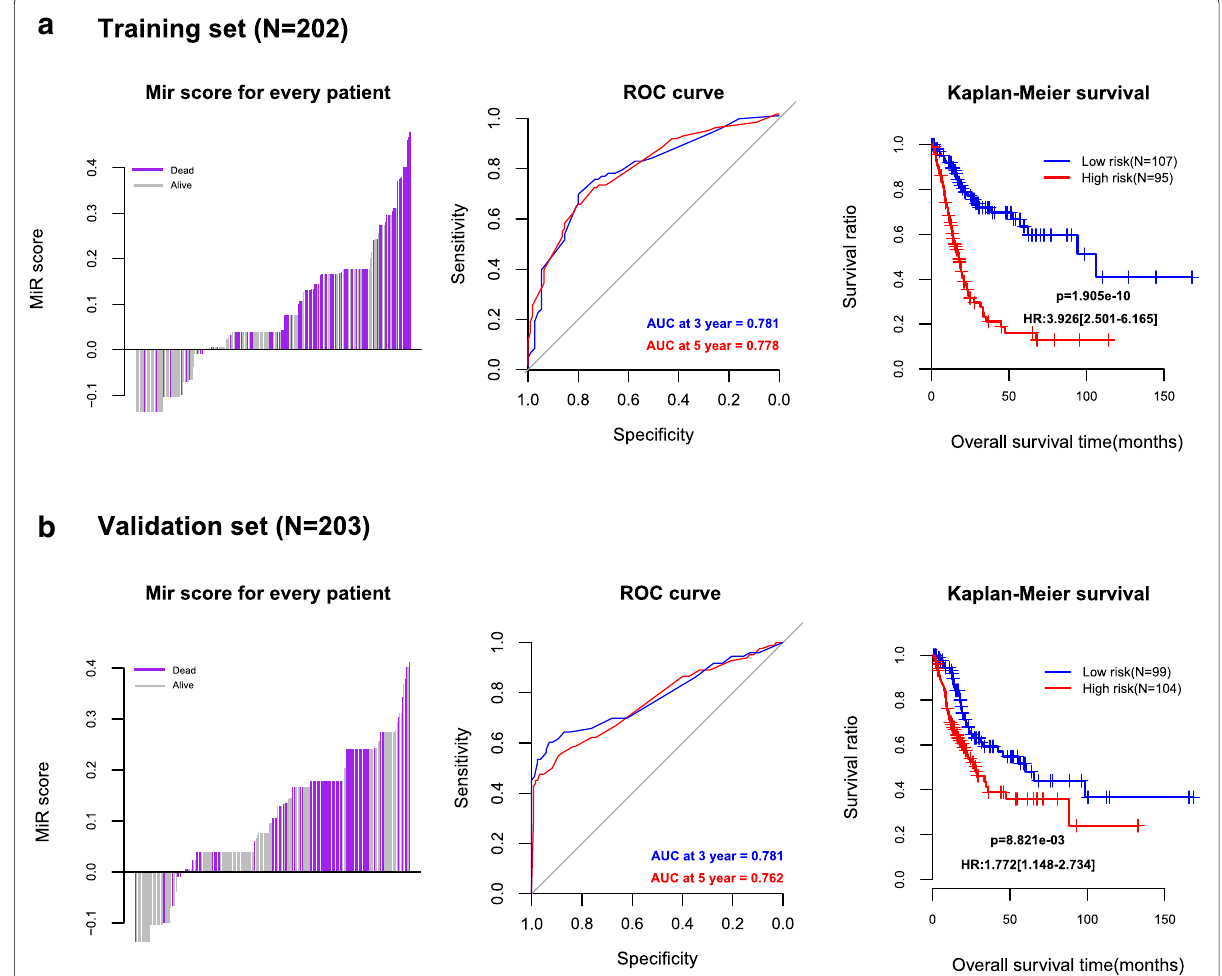
Fig. 3 a The sample distribution ofthe MiR Score in the training set (left), purple and gray bars represent samples of death and survival, respectively; ROC curve analysis of 3- and 5-year survival for MiR Score risk assessment model in the training set (middle); the K–M survival analysis of low- and high- risk groups in the training set (right), HR represents hazard ratio, and the number in parentheses indicates 95% confidence interval (CI). b The sample distribution of the MiR Score in the validation set (left), purple and gray bars represent samples of death and survival, respectively; ROC curve analysis of 3- and 5-year survival for MiR Score risk assessment model in the validation set (middle); the K–M survival analysis of low- and high-risk groups in the validation set (right), HR represents Hazard Ratio, and the number in parentheses indicates 95% confidence interval